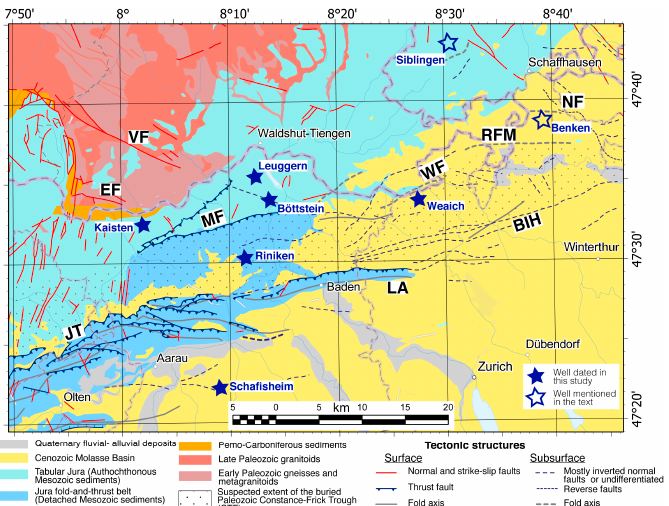
Figure 2. Geological map of the studied region modified from [1,2] showing the different tectonic and sedimentary units, as well as the location of boreholes studied in this work. The structural elements include also subsurface data reported by [4]. The possible extent of the buried Paleozoic Constance–Frick Trough is shown with a dotted pattern (after [4]). Relevant structures shown in the map are as follows: BIH: Baden–Irchel–Herdern Fault zone; EF: Eggberg Fault; JT: Jura Main Thrust; LA: Lägeren Anticline; MF: Mandach Fault/Thrust; NF: Neuhausen Fault; RFM: Rafz-Marthalen Flexure; VF: Vor- wald Fault; WF: Weiach